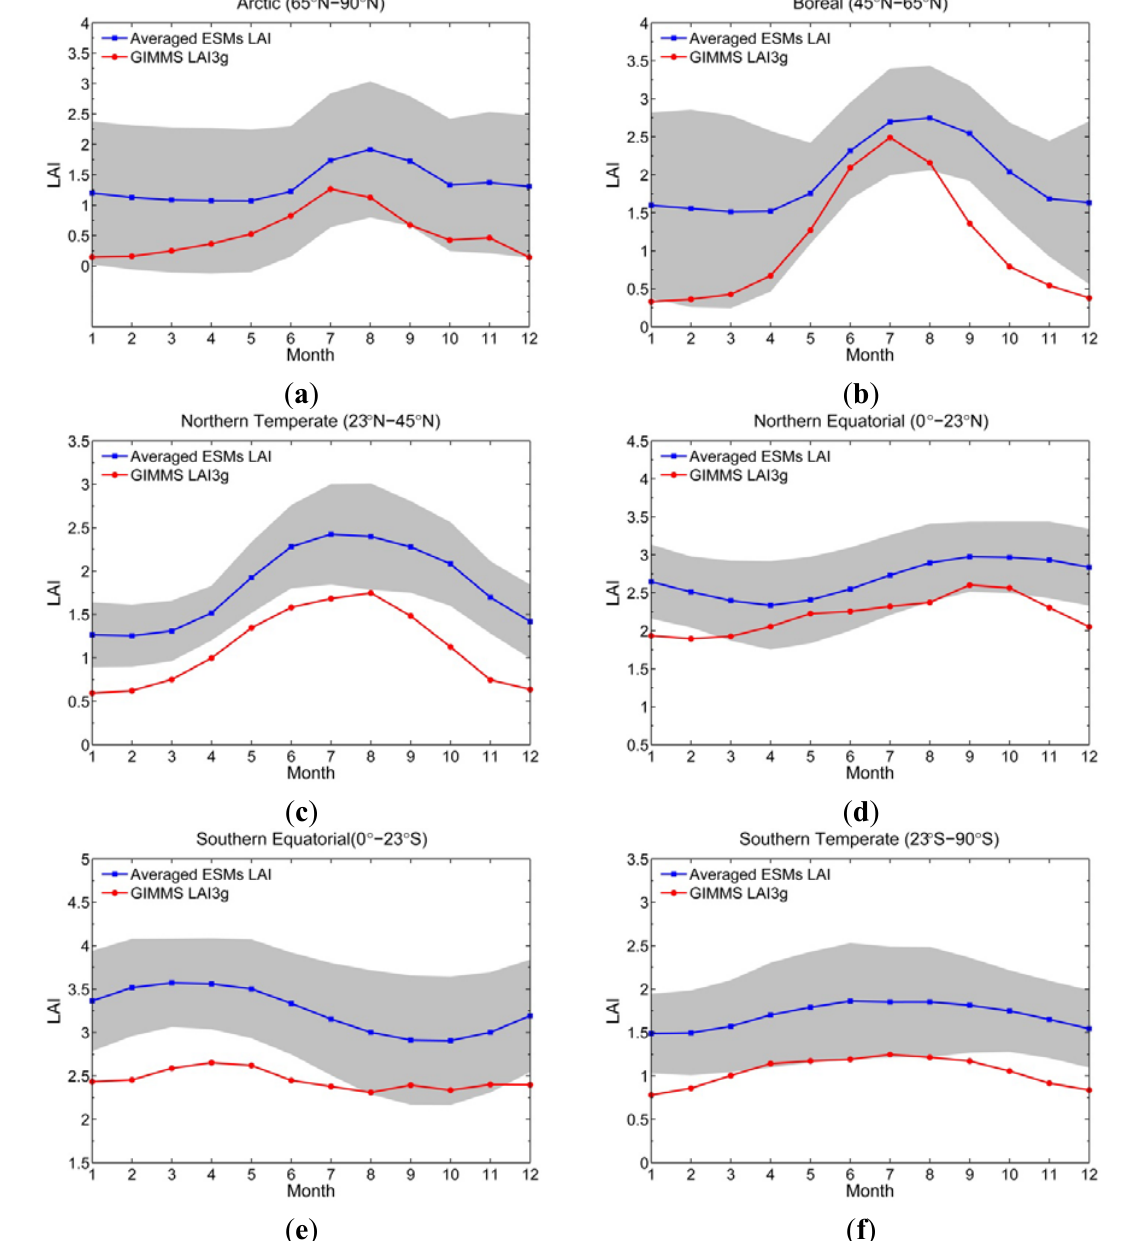
Figure 7. Comparison of 1982 to 2005 average seasonal cycle between LAI simulated by 18 Earth System Models (ESMs) and LAI3g. The shaded area shows the standard variation for the 18 ESMs. This analysis is based on the assumption that ESM LAI is defined with respect to the vegetated area of the model grid cell. In the southern hemisphere, dates for regions south of 23°S are shifted by 6